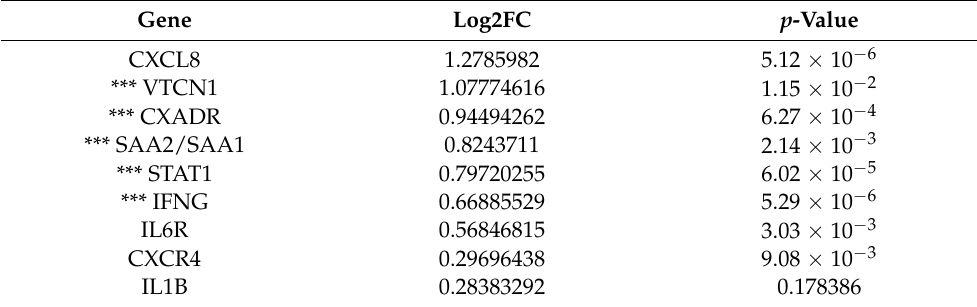
Figure 1. Boxplots of specific interferon signaling genes expressed in African ‐ American obese pa ‐ tients compared to European ‐ American obese patients under gene expression number GSE79858. ( A ) Boxplot of IFNG expression in obese African ‐ Americans (AAOB) compared to obese European ‐ Americans (EAOB). ( B ) Boxplot of STAT1 expression in AAOB vs. EAOB. ( C ) Boxplot of IL10 ex ‐ Table 4. Immunomodulators significantly upregulated in basal-like obese breast cancer patients Table 4. Immunomodulators significantly upregulated in basal ‐ like obese breast cancer patients compared to other subtypes. compared to other subtypes.